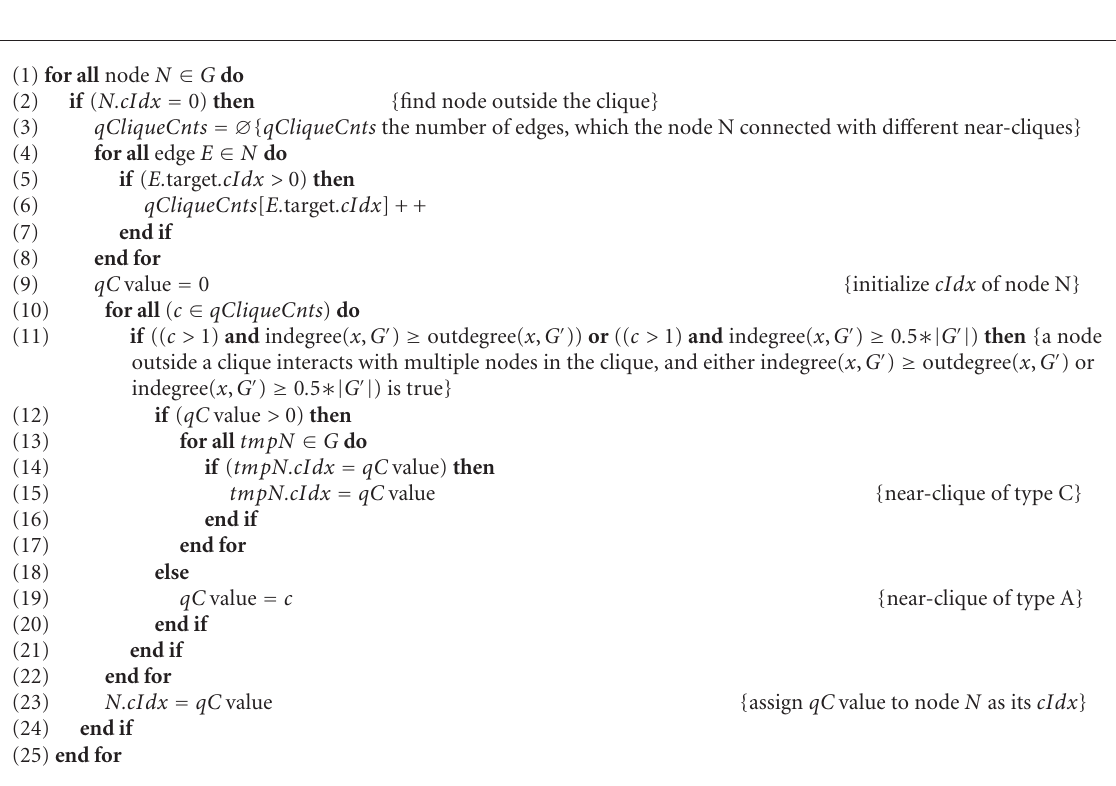
Algorithm 1: AssignNearCliqueIdx.